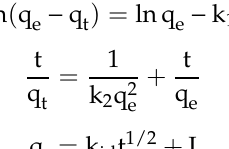
Table 1. Kinetic parameters obtained from pseudo-first-order, pseudo-second-order kinetic and intra- particle diffusion model.